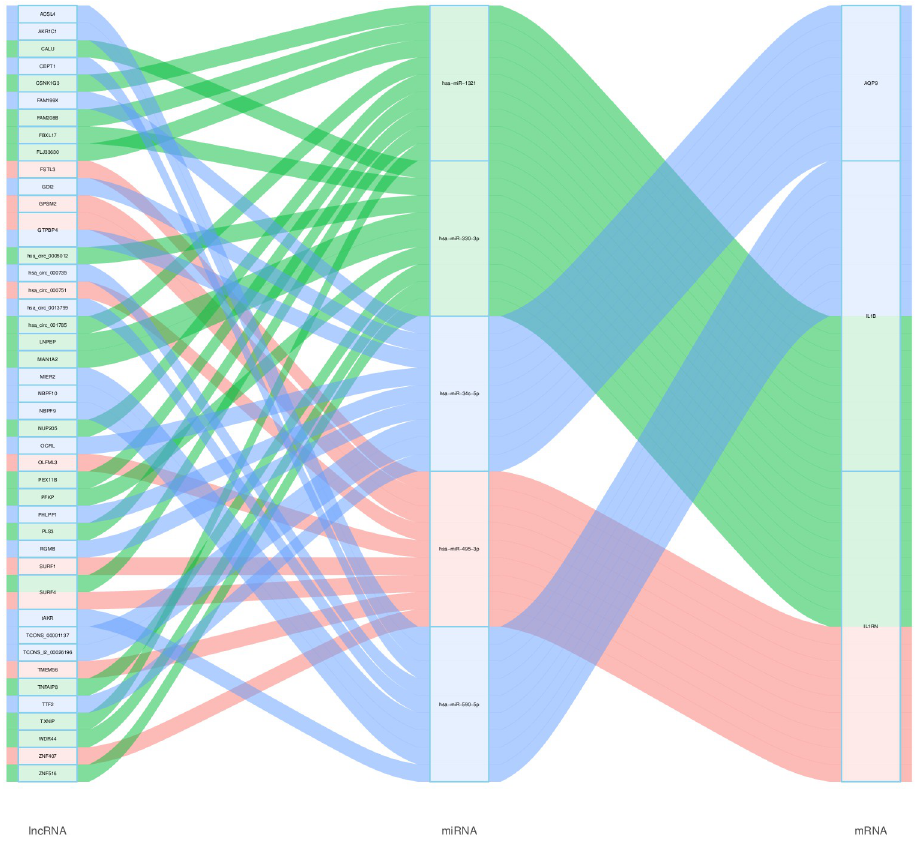
Fig 7. ceRNA networks. Three ceRNA networks comprised AQP9 , IL1B , and IL1RN , as well as possible RNA regulatory mechanisms.